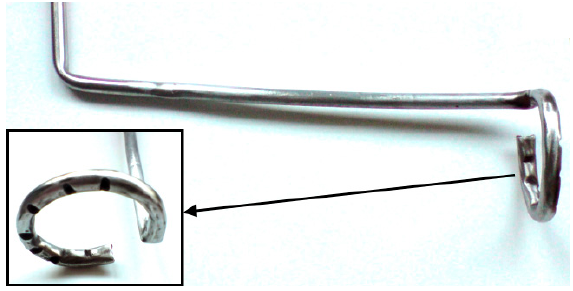
Figure 1. Design scheme ( a ) and photograph ( b ) of experimental Model I of MH-DCFC made of carbon steel.